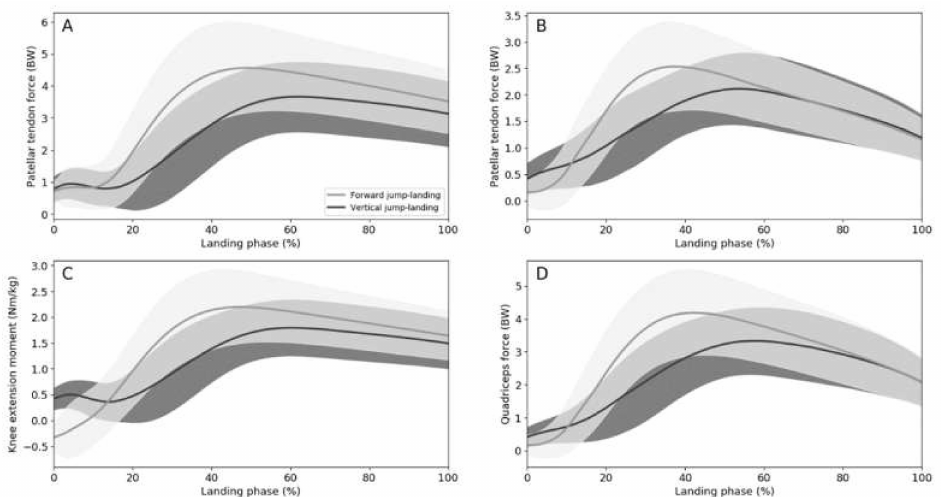
Figure 3. Mean and standard deviation time series graphs of the patellar tendon force estimated with inverse dynamic method ( A ) and static optimization method ( B ), the net knee extension moment ( C ), and the quadriceps force ( D ) for all participants during vertical jump-landing (dark grey) and forward jump-landing (light